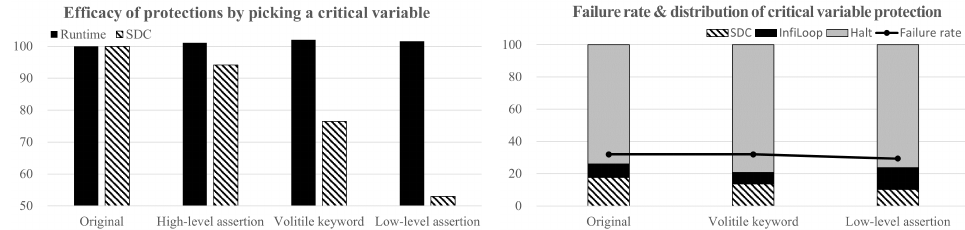
Figure 6. Our protection method, which picks a critical variable, is effective in terms of performance and SDC